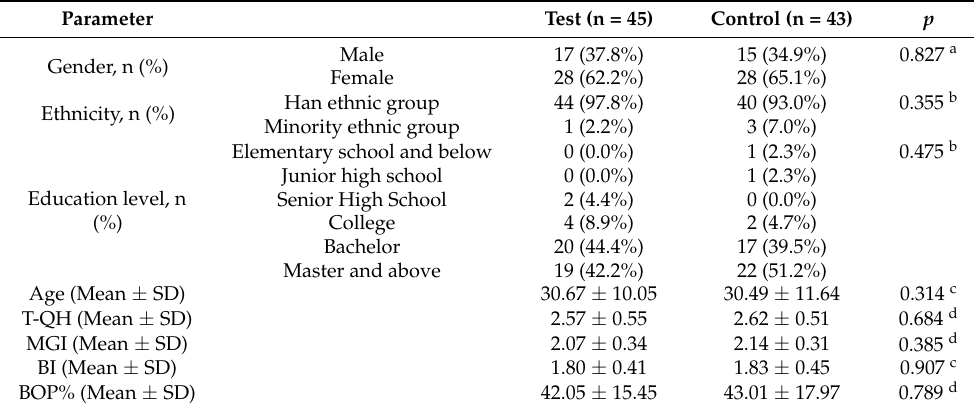
Table 1. Demographic characteristics and the periodontal indices at baseline for two groups (full analysis